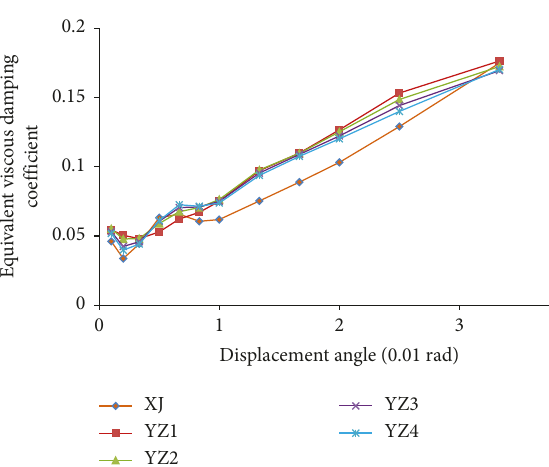
Figure 11: Cumulative hysteretic energy displacement angle re- lation curve.